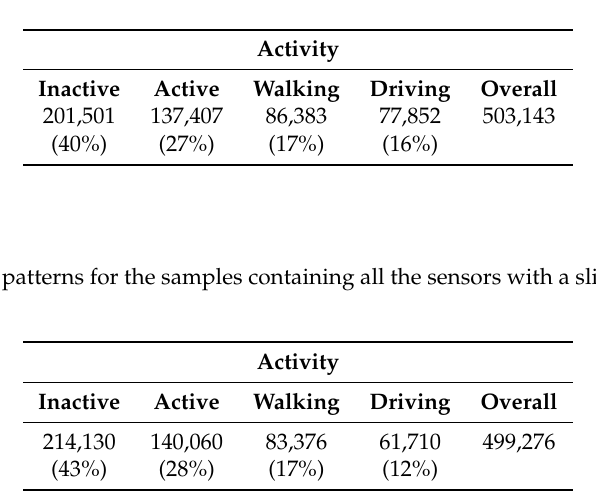
Table 7. Number of patterns for the samples containing all the sensors with a sliding window of 20s and 19s overlap.